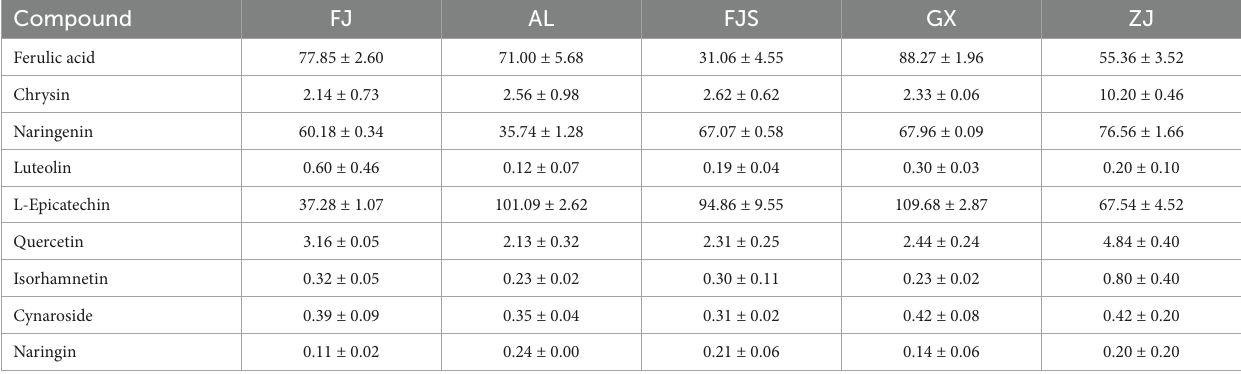
TABLE 5 The content of nine compounds in Dendrobium officinale samples (μg/g). Compound